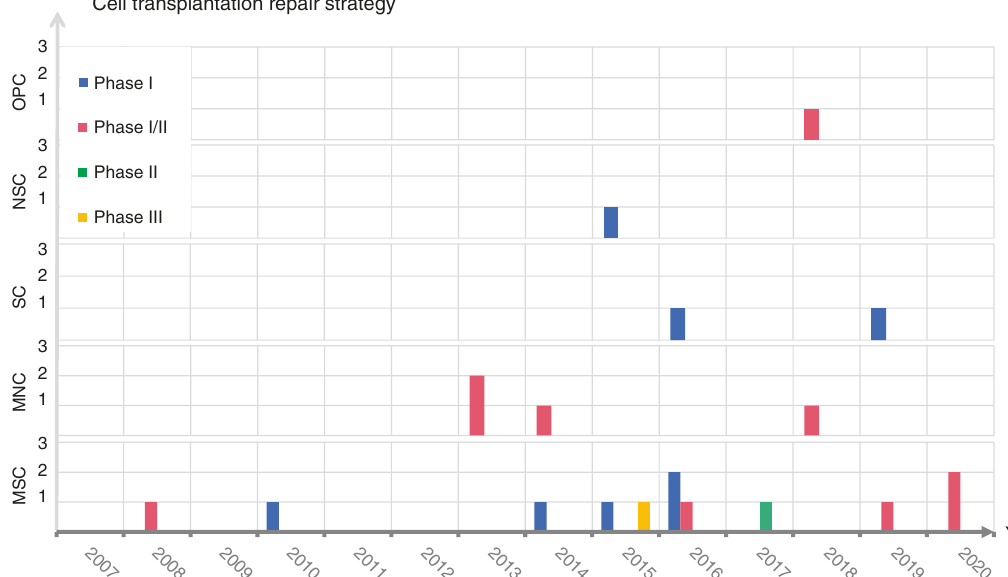
Fig. 6 Research progress on cell therapy for spinal cord injury. This fi gure shows cell therapy clinical trials for SCI that are registered at ClinicalTrials. gov or have been published. This fi gure shows the timeline of cell therapy research for SCI and the number of clinical trials for different